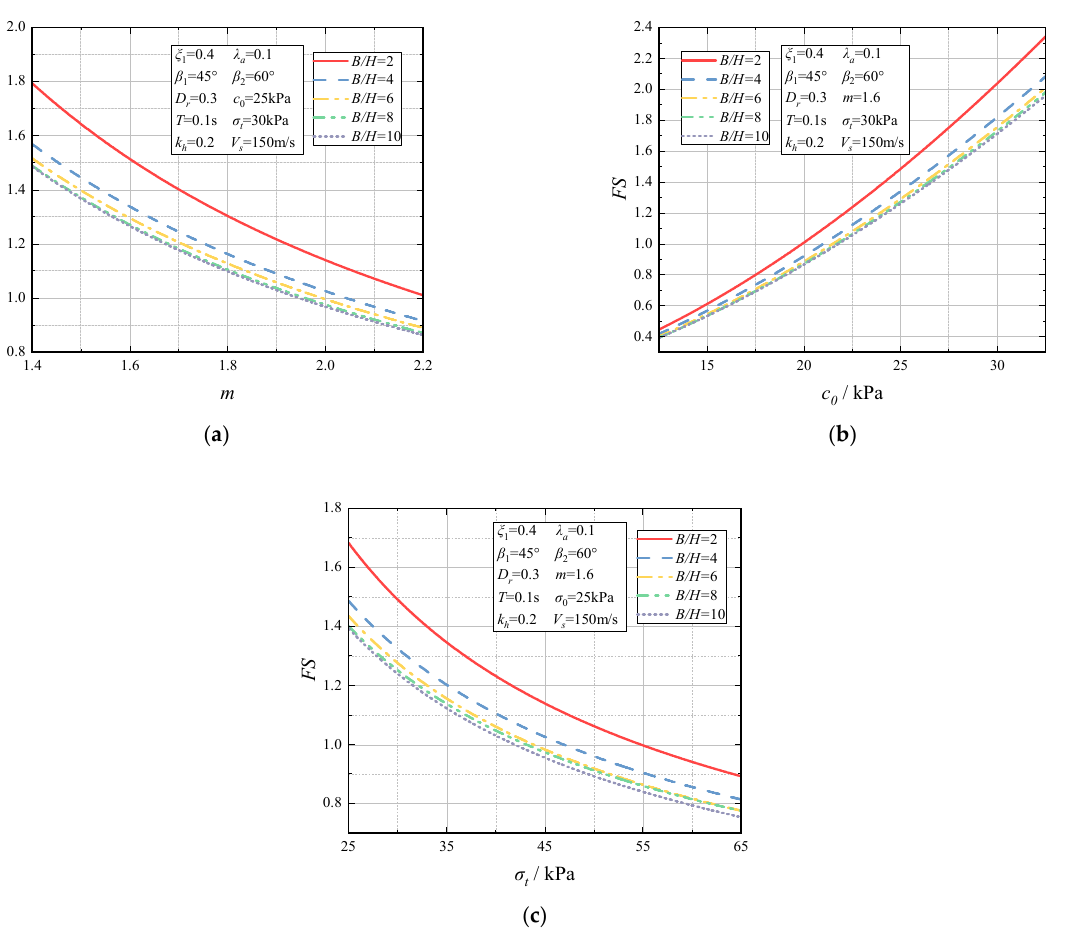
Figure 5. Impacts of nonlinear factors on the stability for 3D two-step slopes: ( a ) nonlinear coefficient m ; ( b ) initial cohesion c 0 ; ( c ) axial tensile strength σ t